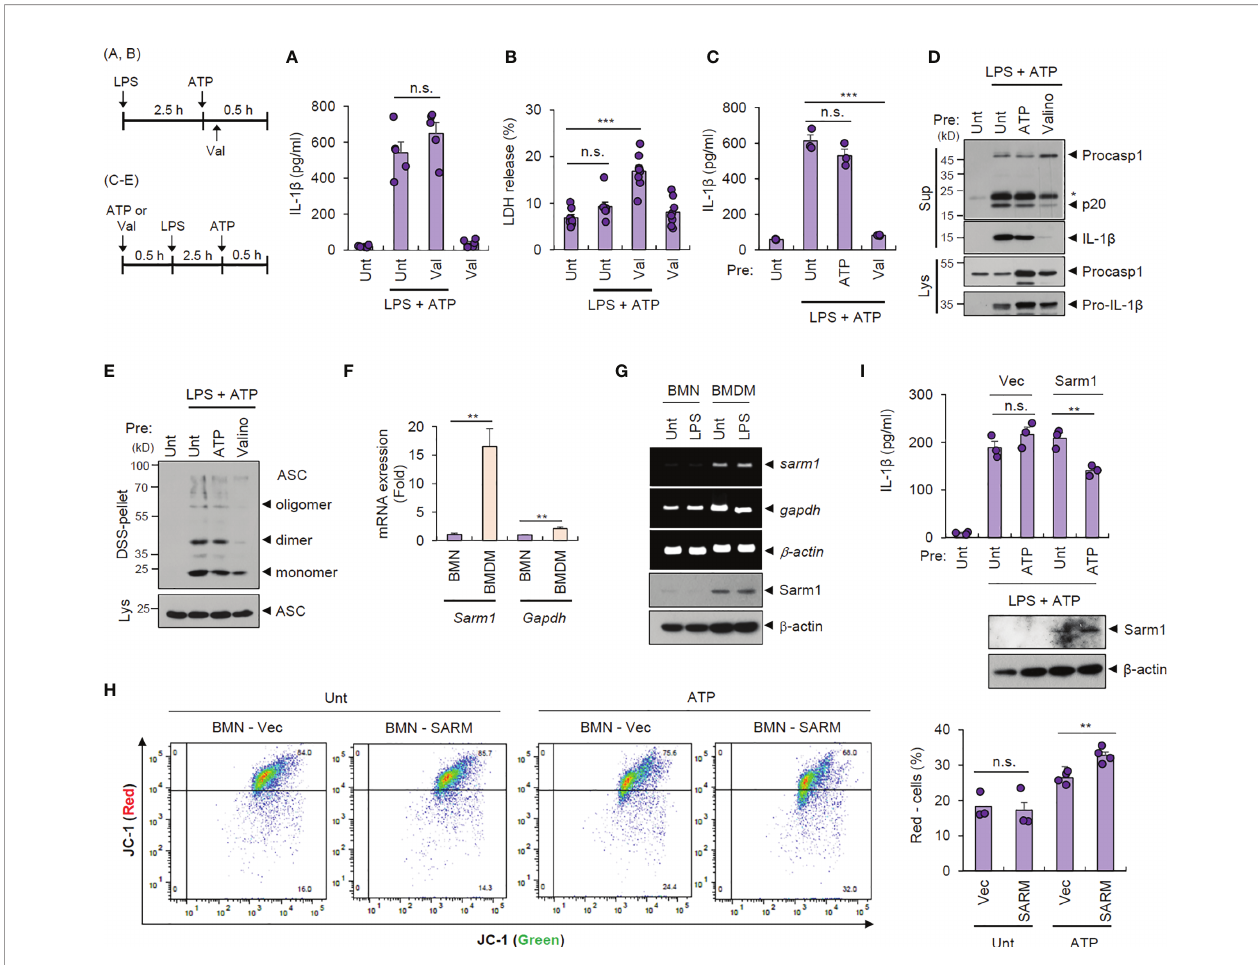
FIGURE 4 | Cell type-speci fi c changes in mitochondrial integrity determine pyroptosis resistance and NLRP3 desensitization. (A, B) Quanti fi cation of IL-1 b (A) or LDH (B) release into the culture supernatant from mouse BMNs primed with LPS (0.25 m g/ml, 2.5 h) followed by ATP (2.5mM, 1 h) treatment in the presence of valinomycin (10 m M, last 50 min) ( n = 5 or 8). (C, D) Quanti fi cation of IL-1 b in the culture supernatant (C) or immunoblots from mouse BMNs pretreated with ATP (2.5 mM) or valinomycin (10 m M) for 30 min, washed and primed with LPS (0.25 m g/mL, 2.5 h) followed by ATP (2.5 mM, 30 min) treatment ( n = 3). The asterisk indicates a nonspeci fi c band (D) . (E) Immunoblots of DSS-crosslinked pellets (DSS-pel) or cell lysates (Lys) from BMNs treated as in (C, D) . (F) Quanti fi cation of sarm1 or gapdh mRNA levels in mouse BMNs or BMDMs ( n = 5). (G) RT-PCR analysis and immunoblots of sarm1 or gapdh in mouse BMNs or BMDMs untreated or treated with LPS (0.5 m g/mL, 3 h). (H) Mouse BMNs were transfected with vector or Sarm1-expressing construct using DOTAP liposomal reagent and then treated with ATP (2.5 mM, 1 h). Flow cytometric analysis of these cells after JC-1 staining (left panel). Quanti fi cation of JC-1 (red)-negative mouse BMN populations (right panel, n = 3 or 4). (I) Quanti fi cation of IL-1 b (upper panel) or immunoblots (lower panel) of mouse BMNs transfected with empty vector or Sarm1-expressing construct, and treated with ATP (2 mM, 20 min), and then treated with LPS followed by ATP treatment. ( n = 3). Culture supernatants (Sup) or cell lysates (Lys) were immunoblotted with the indicated antibodies. ** P < 0.01, *** P < 0.001, n.s., not signi fi